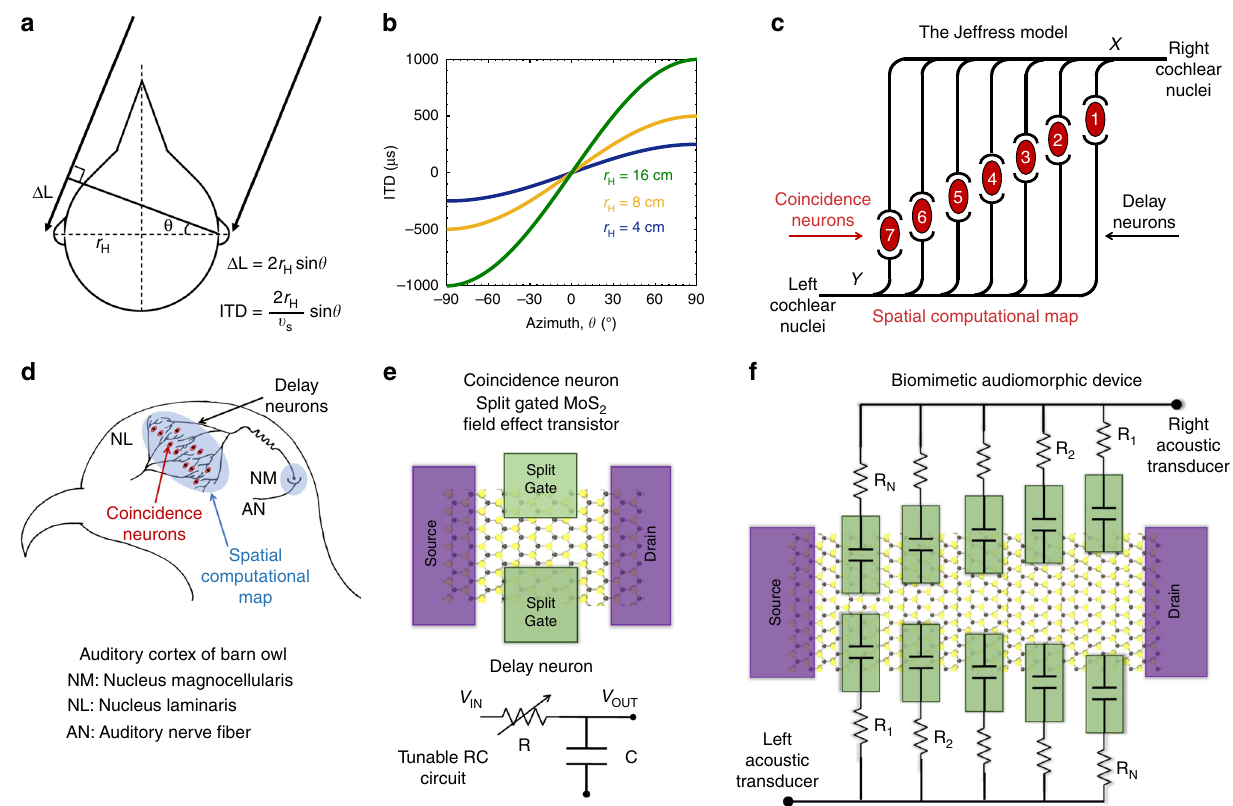
Fig. 1 Biomimicry of auditory cortex of barn owl. a Path difference between the sound waves reaching the two ears and the corresponding interaural time difference (ITD) for an acoustic source located at an azimuth, θ , for a given head radius ( r H ) and sound velocity ( v s ). b ITD as a function of θ for different head sizes. For typical size of animal heads, ITDs are in the range of hundreds of μ s, while neuronal fi ring occurs only once per few ms which makes the auditory information processing a challenging task for any animal. c The Jeffress model showing the neural computational map in the auditory cortex for transforming temporal coding into spatial coding by deploying two key neural elements — the time delay neurons and the coincidence detector neurons. The coincidence neurons fi re only when spikes arrive concurrently at the corresponding delay neurons. The delay neurons are projected onto coincidence neurons in a ladder- like branching structure. If a sound originates from straight ahead, it will reach the right and left cochlea at the same time. In this case only neuron 4 will receive coincident inputs. However, if the sound originates from the left hemisphere, it will reach the left ear earlier and coincidence will occur if the input signal from the left travels a longer path length that exactly offsets the acoustic delay, e.g., at cell 1. Similarly, if the sound originates from the right hemisphere, coincidence will occur e.g., at cell 7. The spatial projection of the delay neurons onto the coincidence neurons form a computational map where each coincidence neuron represents a speci fi c ITD corresponding to an azimuth. d An anatomical drawing of barn owl ’ s brainstem showing remarkable similarity with the Jeffress model. Axons from the nucleus magnocellularis (NM) provide the delay lines, whereas, binaural tertiary nerve fi bers serve as coincidence detectors in the nucleus laminaris (NL). e Schematic of solid state coincidence neuron and delay neuron. Split-gated MoS 2 fi eld effect transistors (FETs) are used to achieve the functionality of coincidence neurons and tunable RC circuits are used as delay neurons. f A fully integrated biomimetic audiomorphic device emulating the neural computational map involving multiple split-gates with different widths of the ungated region on a single MoS 2 channel. Each split- gate is connected to a delay line resistor with the resistance value designed in accordance with the spatial location of the corresponding